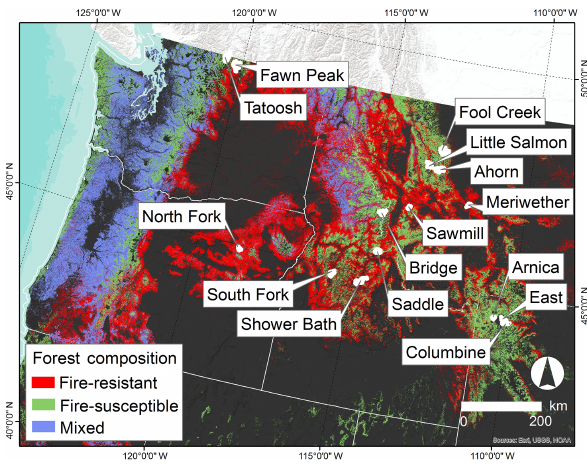
Figure 1. Location of study fires overlaid on the pre-fire distribution of US forest types classified using relative fire resistance informa- tion in the literature and the LANDFIRE Existing Vegetation Type (EVT) 30m